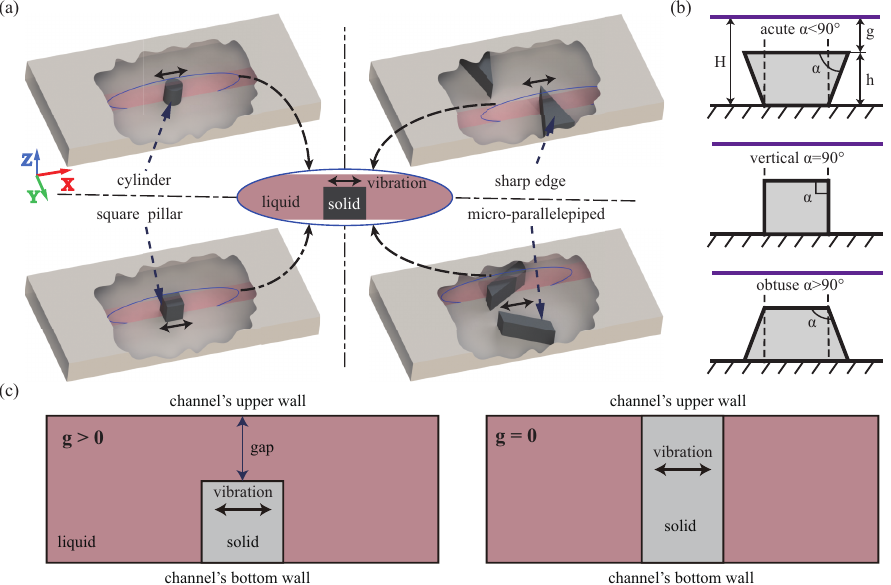
Figure 1. The diagram of microstructure-induced streaming device and microstructure sidewall. ( a ) The common microstructures of devices in the channel include microcylinders, sharp edges, micro square pillars, and micro parallelepipeds, where solid line with black arrow is the direction of microstructure vibration. The longitudinal section of the microstructure is enlarged and displayed in the middle, in which the pink plane is the section, and the blue ellipse is the section outline. The pink plane is one of a series of viewing planes at various focal lengths. ( b ) The ideal sidewall of microstructure, prepared by photolithography or soft lithography, is vertical as the dotted line which is the designed optical path through the masks. But the sidewall profile angle α caused by errors in actual processing can be classified into acute, vertical, and obtuse. Where H is the channel height, h is the microstructure height, g is the gap, and the purple line denotes the upper wall. ( c ) The upper wall’s position of microstructure induced streaming in channel can be classified as g > 0 and g = 0. The latter implies that the channel’s upper wall is connected to the microstructure, which is not the case in our